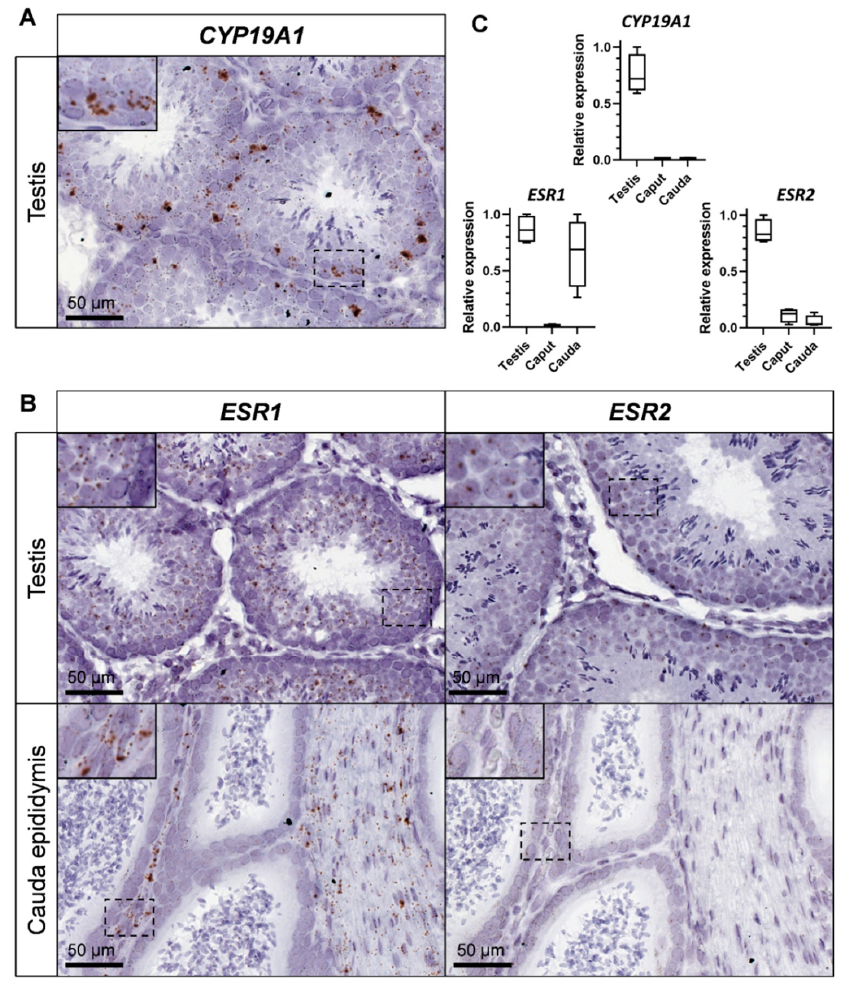
Figure 1. CYP19A1 and estrogen receptors expression in the testis and epididymis of adult rabbits. ( A ) Location of CYP19A1 expression by in situ hybridization (RNAscope technology) in the adult testis. ( B ) Location of ESR1 and ESR2 expression by in situ hybridization in the testis and the cauda epididymis. ( C ) Relative expression levels of CYP19A1, ESR1 and ESR2 analyzed by RT ‐ qPCR in the adult testis and epididymis (caput and cauda). Testis n = 4; Epididymis n = 4. The expression level of both aromatase and estrogen receptors transcripts was studied and compared within testes and epididymides ( caput and cauda ) by RT ‐ qPCR